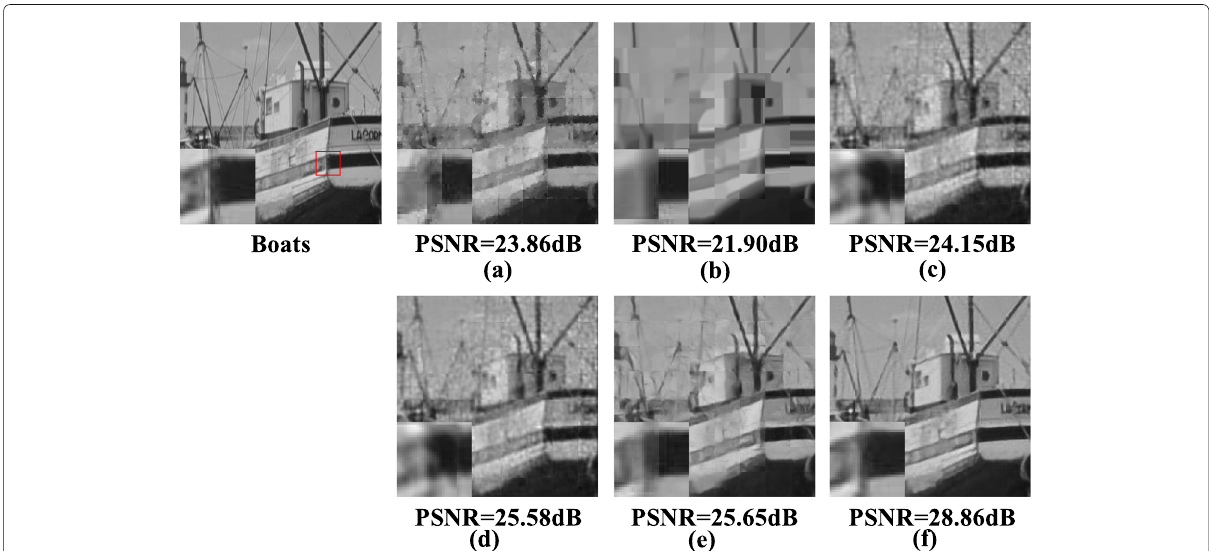
Fig. 11 The reconstruction results of Boats at the measurement rate of 0.1 without BM3D. a TVAL3. b DAMP. c ReconNet. d DR 2 -Net. e CSRNet. f ASRNet